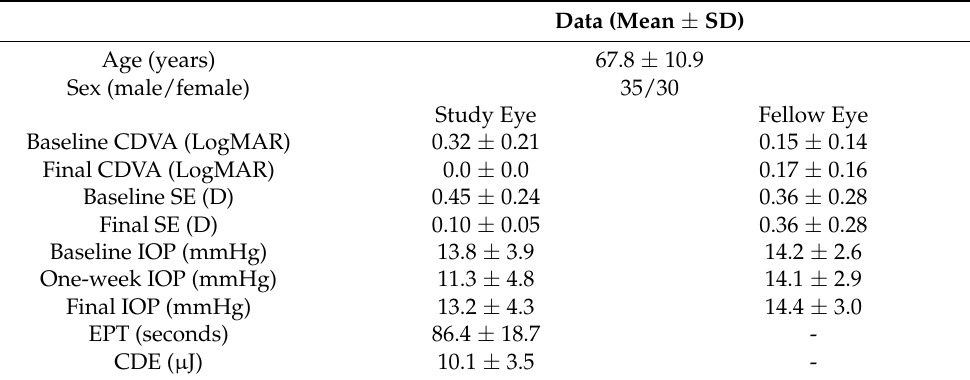
Table 1. Demographic characteristics of the study cohort and main intraoperative and functional outcomes.